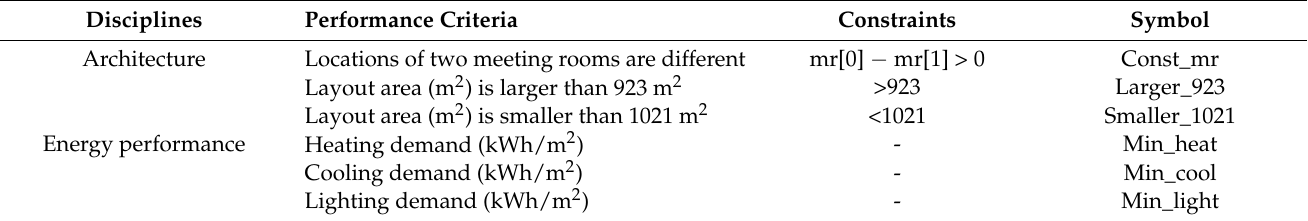
Table 3. Outputs and